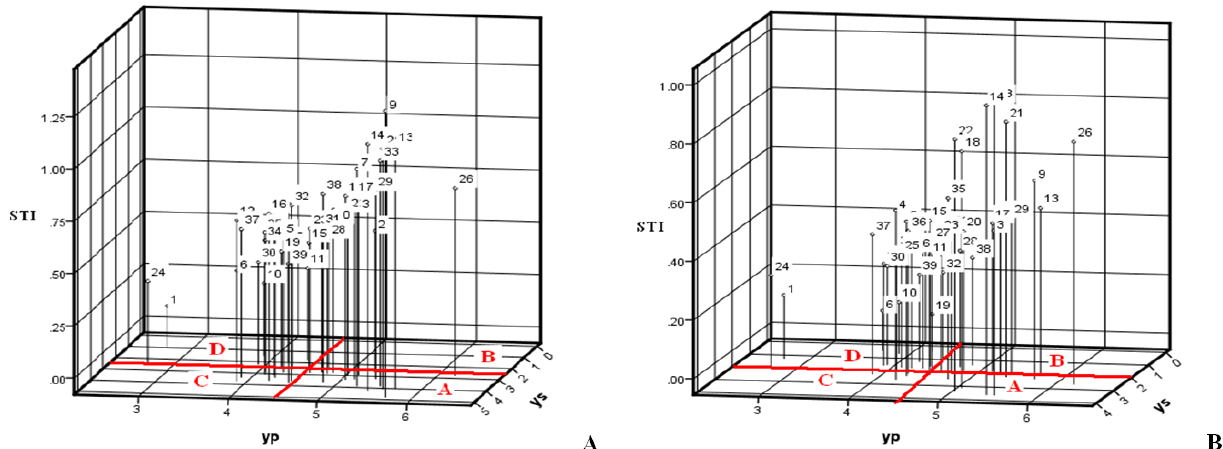
Fig. 2. 3D plot of cultivars based on STI index. A (2/3 continuous irrigation), B (1/3 continuous